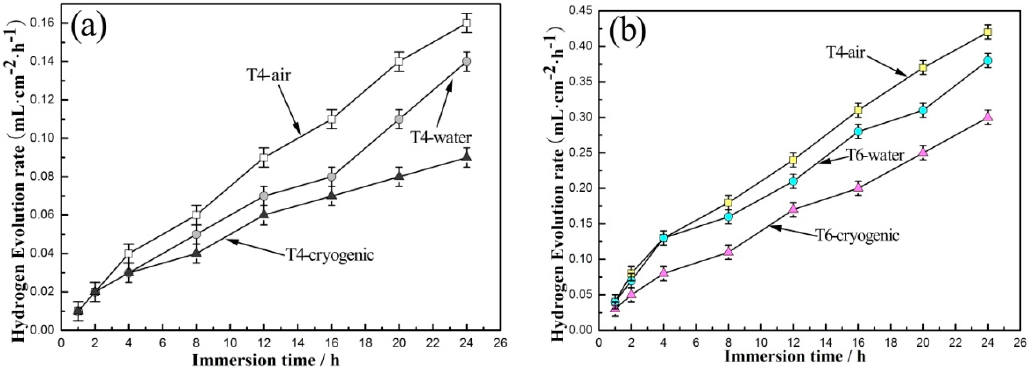
Figure 10. Average hydrogen evolution rates of different samples: ( a ) T4; ( b ) T6.